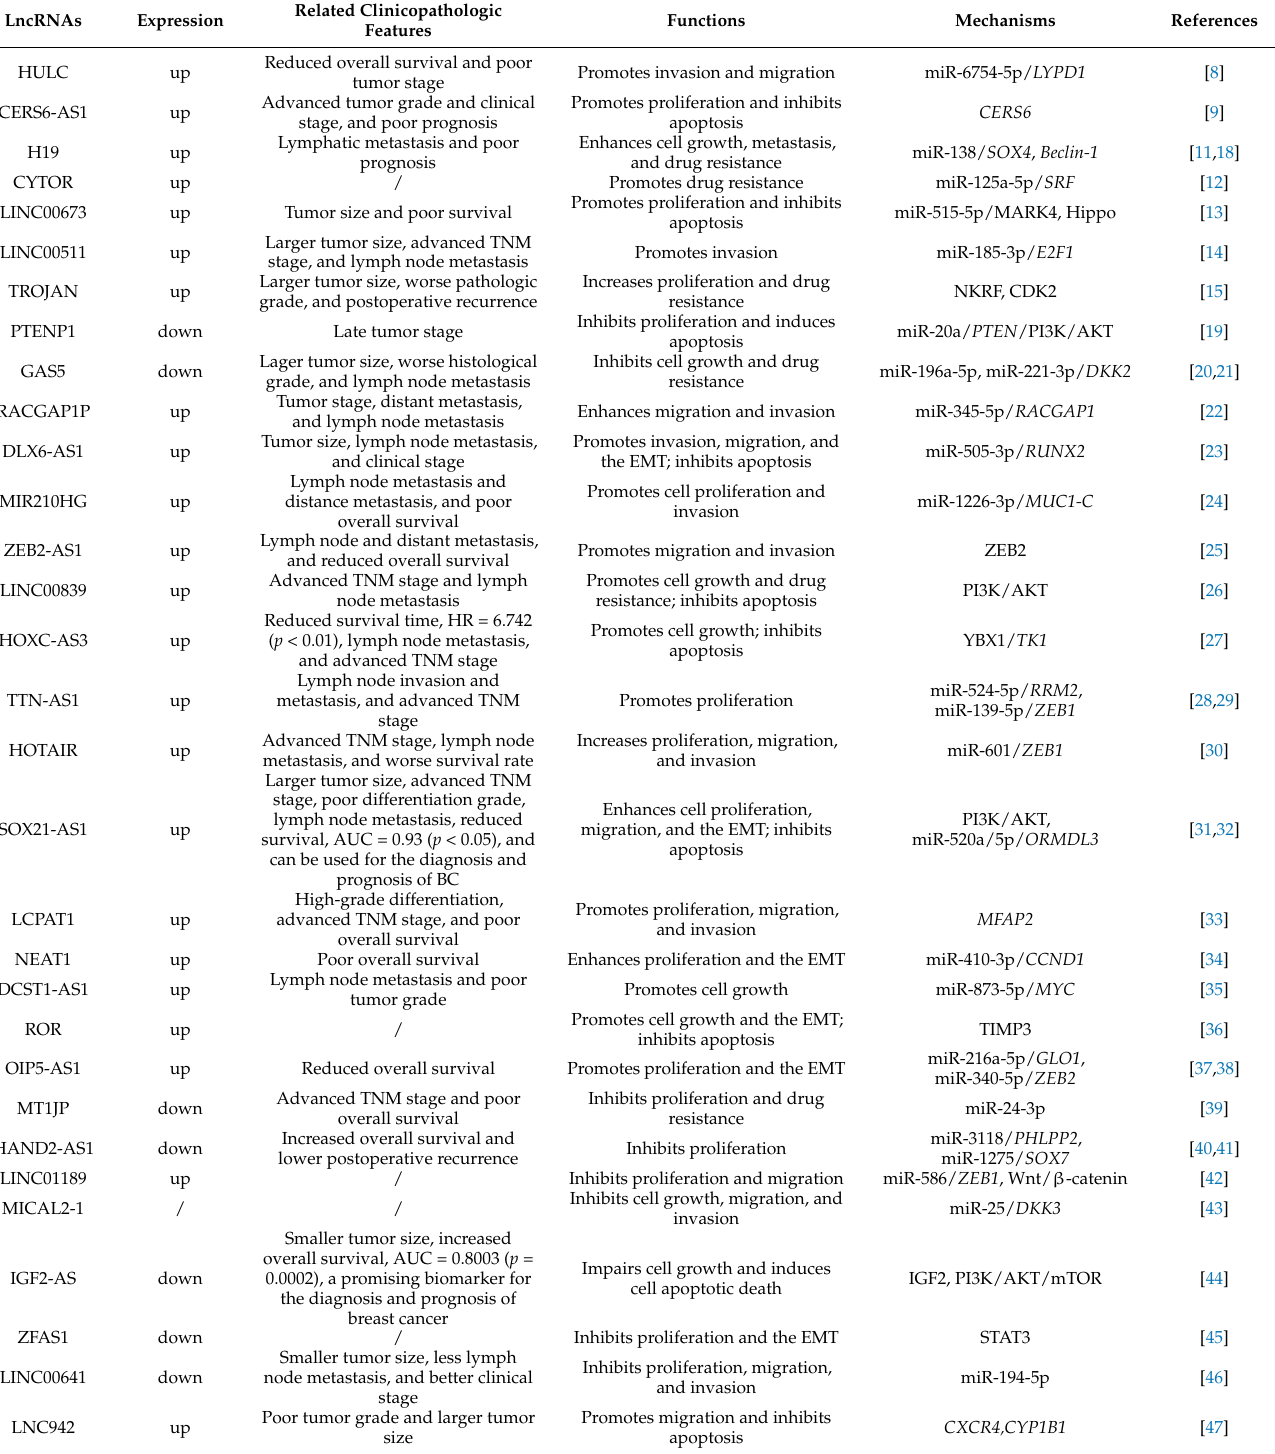
Table 1. Regulatory roles and clinical features of representative lncRNAs in breast